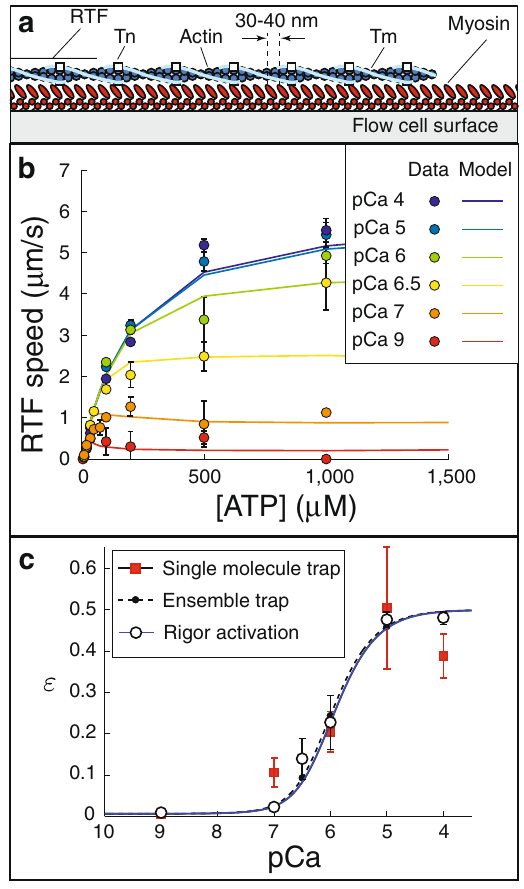
Figure 4. Measurements of the effect of Ca ++ on the ATP-dependence of the speed of regulated thin filaments (RTFs) in the in vitro motility assay. ( a ) Cartoon of the in vitro motility assay (not to scale). ( b ) The model reproduces the Ca ++ -dependence of RTF speed as a function of ATP. Note the biphasic behavior at low Ca ++ (pCa 7 and 9). Data (circles) are means, error bars show S.E.M. Parameters used in the simulations were N mot = 75, K = 0.217 μ M. ( c ) Single molecule myosin binding frequency ( ε ), predicted by fitting the model to motility measurements at each Ca ++ concentration (hollow circles, error bars show S.D.), agree with our direct, single molecule measurements (data, red squares; error bars, S.D.; best fit, black solid line) and our indirect estimate from fits to the mini-ensemble measurement (dashed line). These individual fits to the in vitro motility data are well-described by equations (1) and (2), with K = 0.217 μ M (blue solid